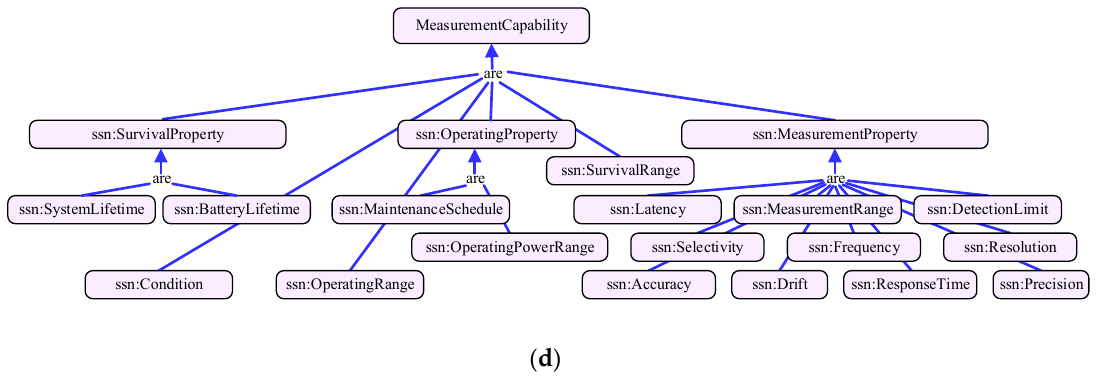
Figure 1. Parts of multidimensional service model. ( a ) Measurement principle dimension; ( b ) Measurement quantity type; ( c ) Application domain dimension; ( d ) Measurement capability dimension